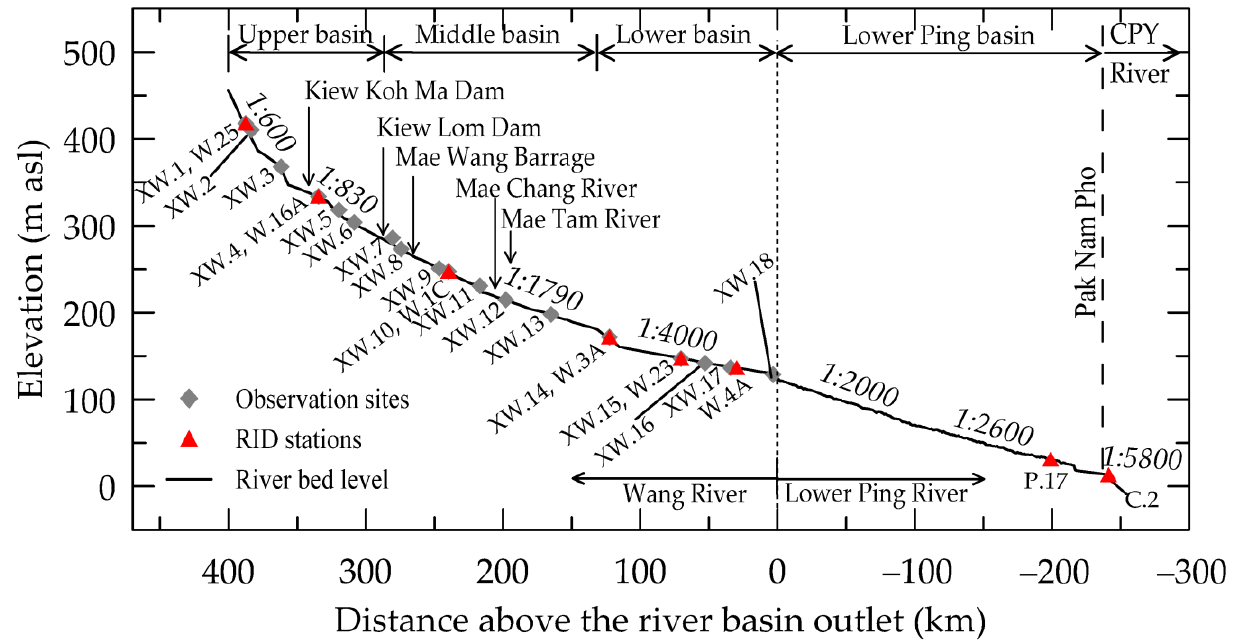
Figure 2. Longitudinal profile of the Wang River showing locations of RID hydrological stations (red triangles) and observation sites (grey diamonds). The zero mark on the x -axis represents the Wang River outlet.